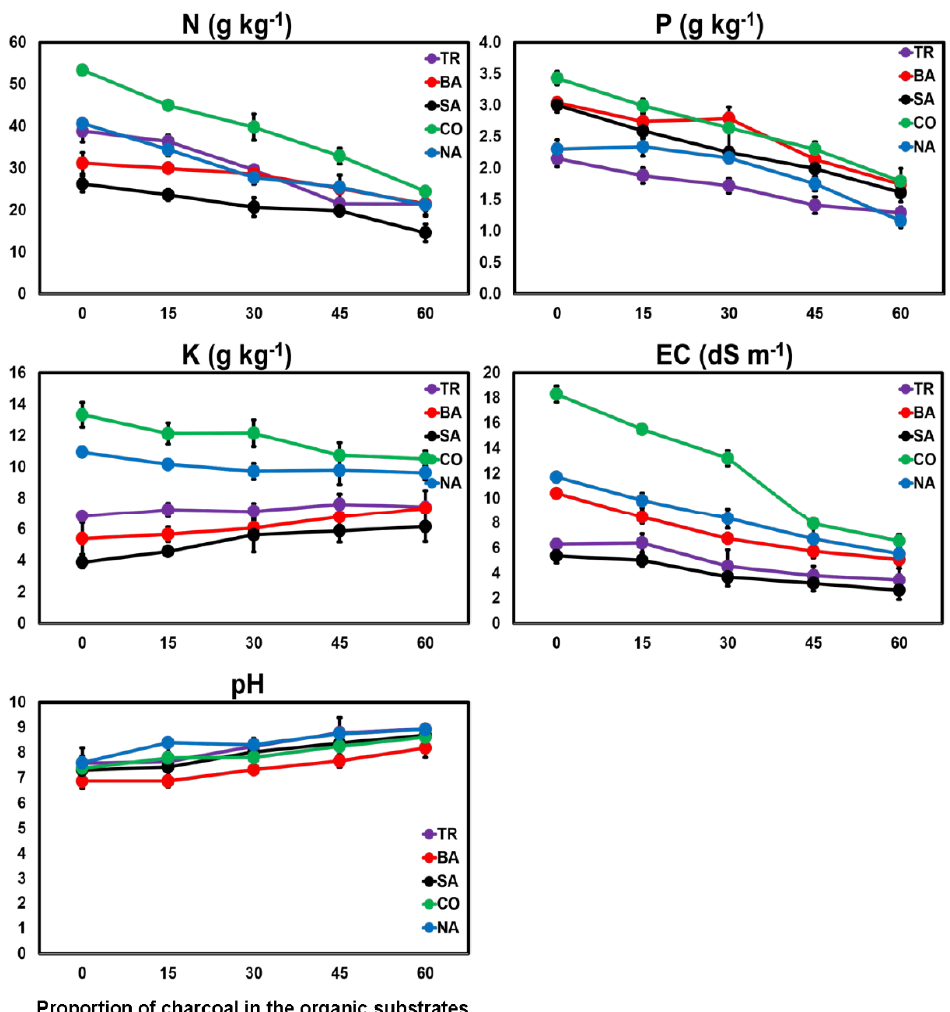
Figure 3. Mineral content (N, P, K), electrical conductivity (EC), and pH of organic amendments made from mixtures of composts and charcoal. Composts were made from poultry industry wastes and tree trimmings (TR), sugarcane bagasse (BA), sawdust (SA), cotton residues (CO), and Napier grass (NA). The numbers 0, 15, 30, 45, and 60 correspond to the proportion of charcoal in the organic amendment (%, weight basis). Error bars represent standard deviations.